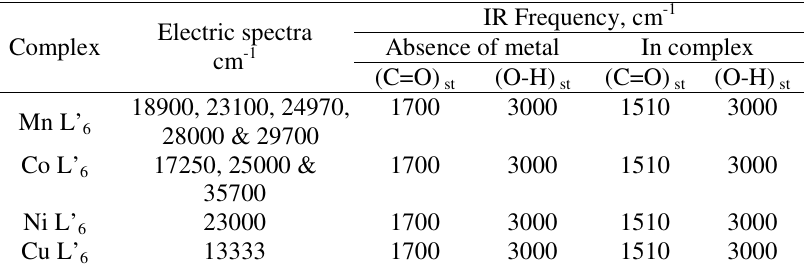
Table 3. Electronic and IR spectral data.